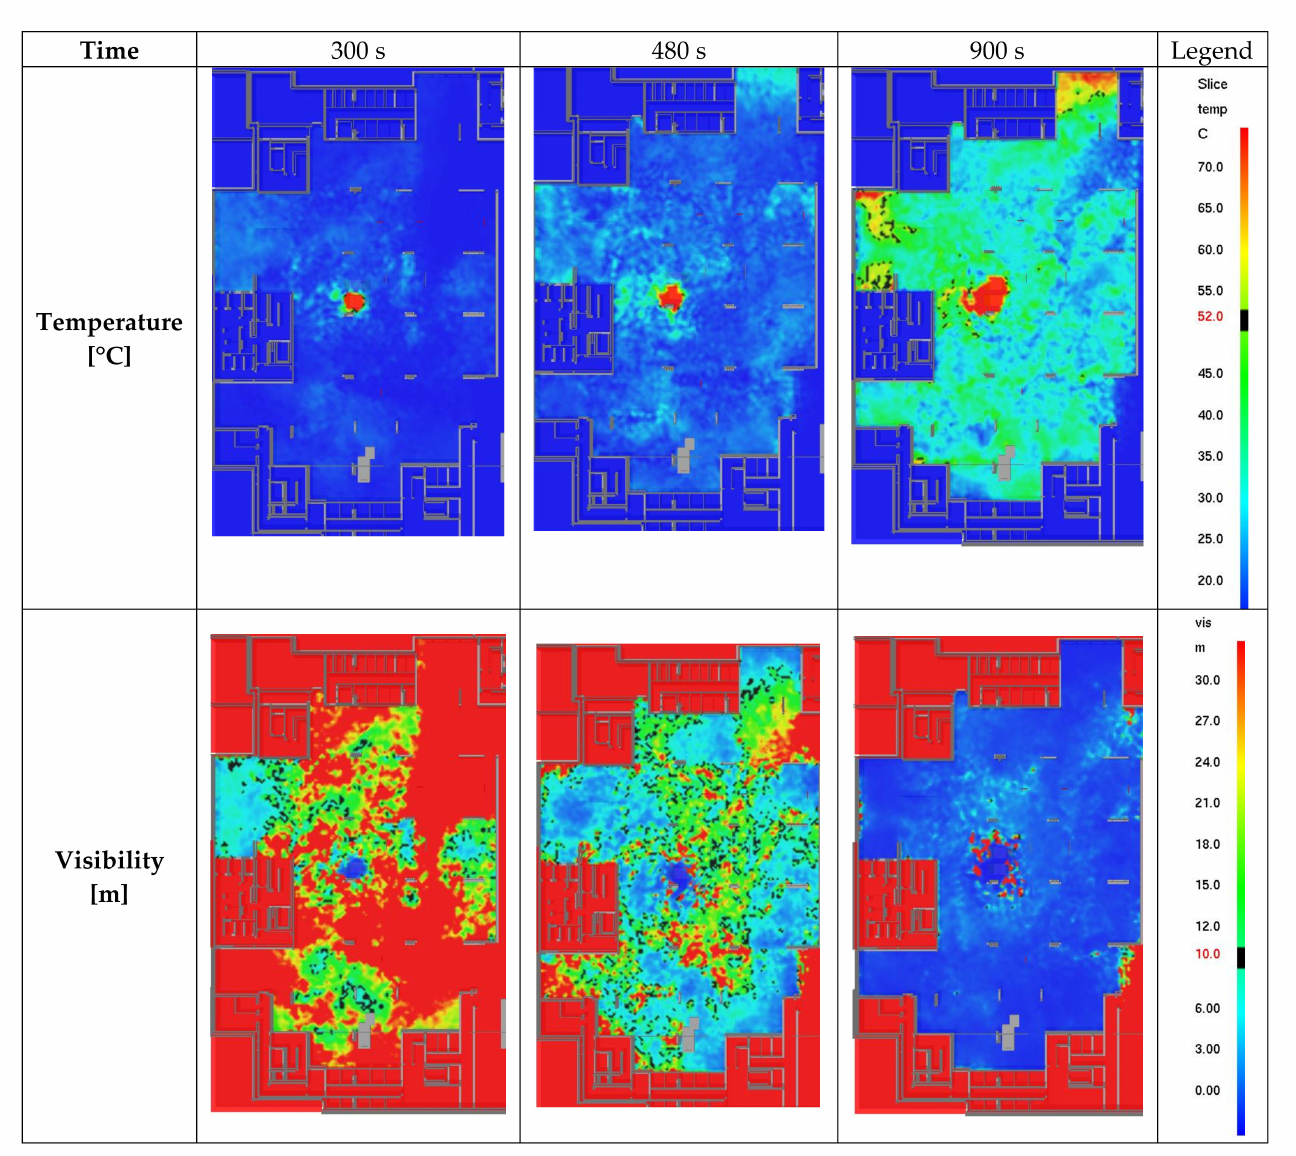
Figure 7. Graphical presentation of the CFD simulation